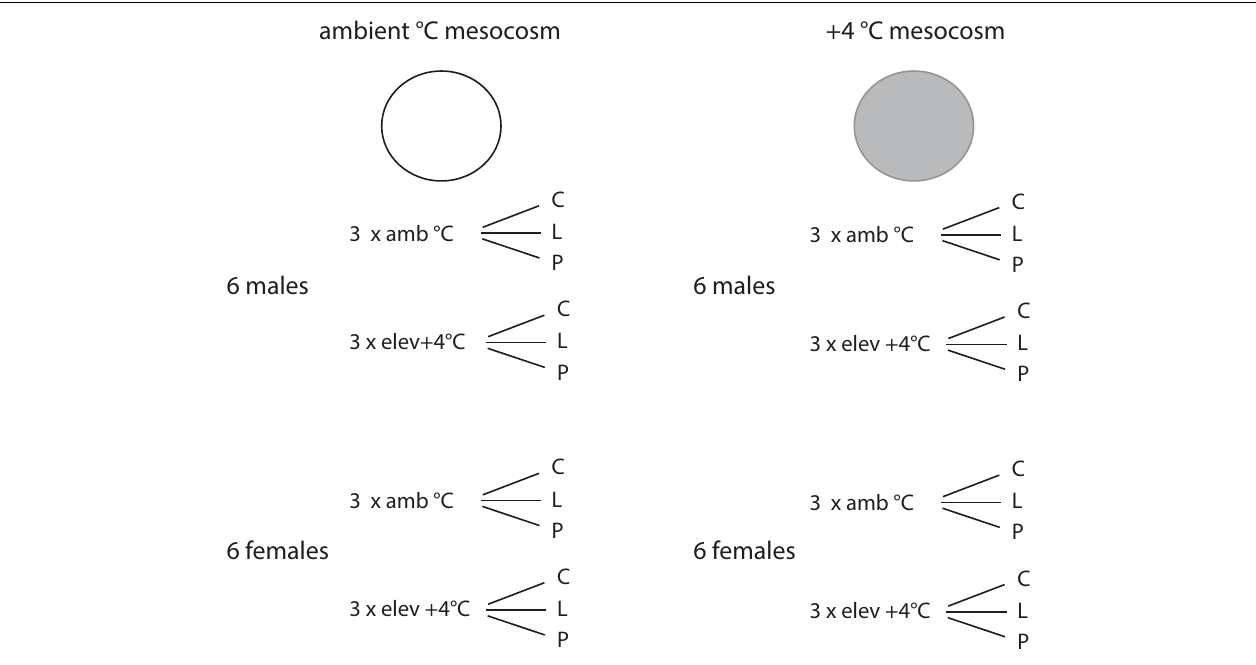
FIGURE 1 | Experimental design schematic showing the combination of six males and six females from different temperature acclimation treatments (ambient, +4 ◦ C climate change scenario) and different plate morphs (c, complete; l, low plated; p, partial) in mesocosms set to either ambient or elevated (+4 ◦ C) temperature.